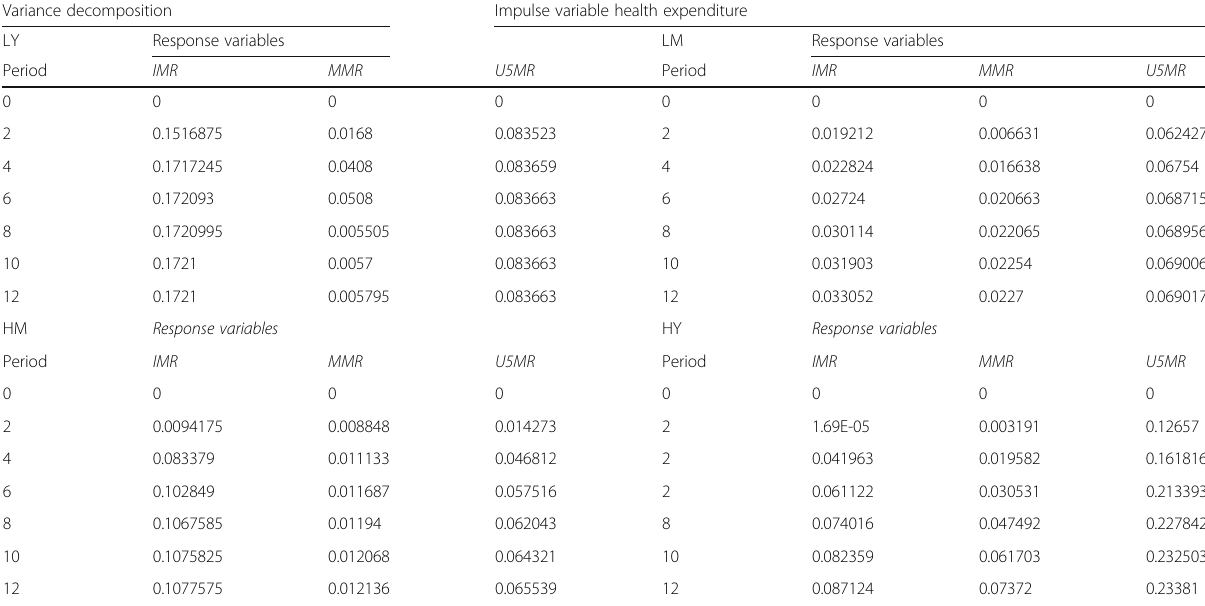
Table 7 Forecast-error variance decomposition test (income group comparison) Variance